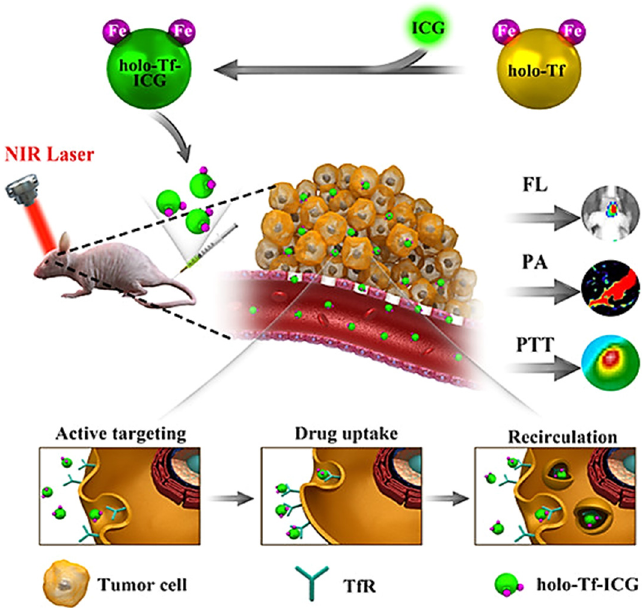
Figure 5. Conjugation of ICG to holo-transferrin (holo-Tf), followed by self-assembly into holo-Tf- ICG nanoparticles for tumor-targeted photoacoustic (PA) and fluorescence (FL) imaging-guided photothermal therapy (PTT) of glioma. Reproduced with permission from [76]. Copyright 2017. American Chemical Society.